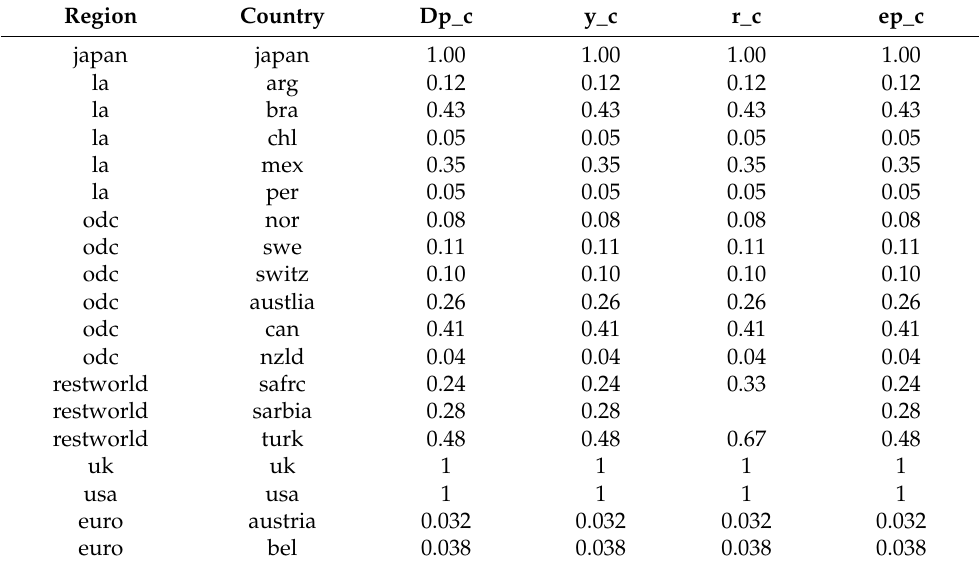
Table A6. Regional Weights